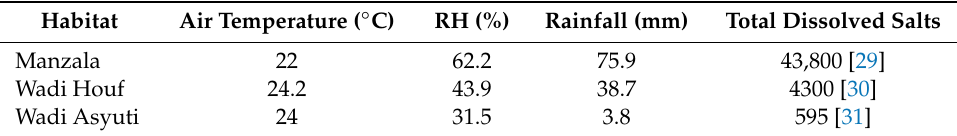
Table 2. The mean annual weather conditions of last five years of three habitats. Habitat Air Temperature ( ◦ C) RH (%) Rainfall (mm) Total Dissolved Salts Manzala 22 62.2 75.9 Wadi